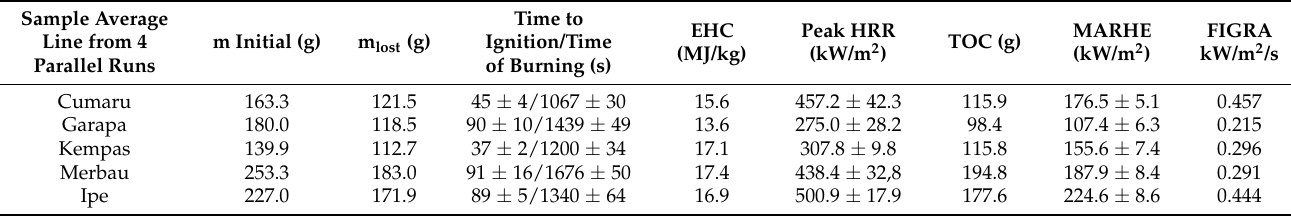
Table 3. Parameters read from cone calorimetry measurements of tropical wood samples C (Cumaru), G (Garapa), K (Kempas), M (Merbau) and I (Ipe). Average from 4 parallel experiments. Sample Average Line from 4